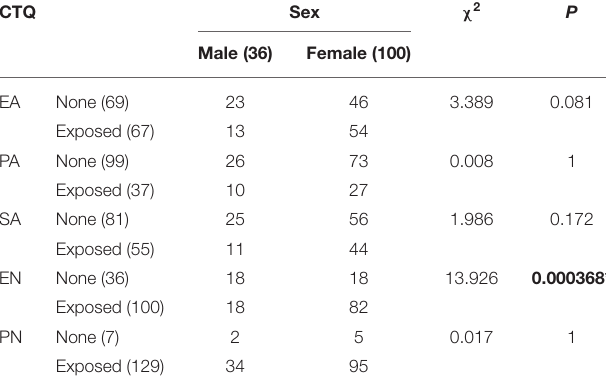
TABLE 2 | Analysis of CTQ and sex. TABLE 3 | Distribution of 5 SNPs in NEDD4 in patients with schizophrenia and